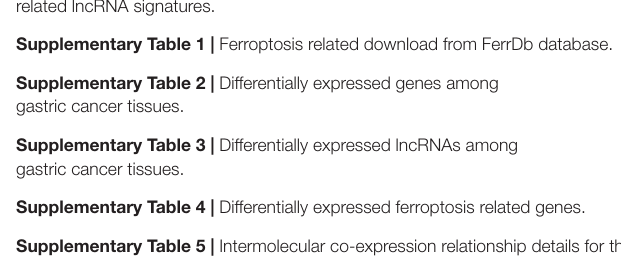
Supplementary Table 1 | Ferroptosis related download from FerrDb database. Supplementary Table 2 | Differentially expressed genes among gastric cancer tissues. Supplementary Table 3 | Differentially expressed lncRNAs among gastric cancer tissues. Supplementary Table 4 | Differentially expressed ferroptosis related genes.